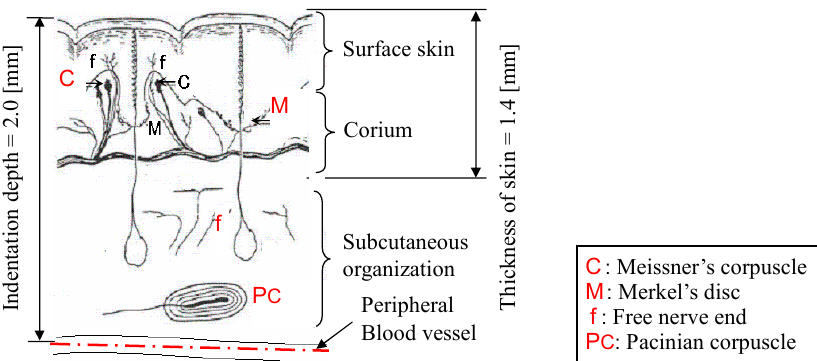
Figure 13. Consideration of indentation depth for either blood suction or drug delivery.